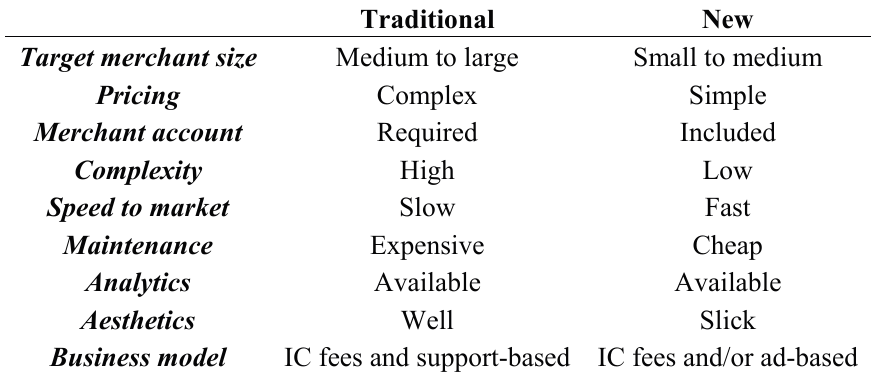
Table 2. Traditional POS and mPOS.